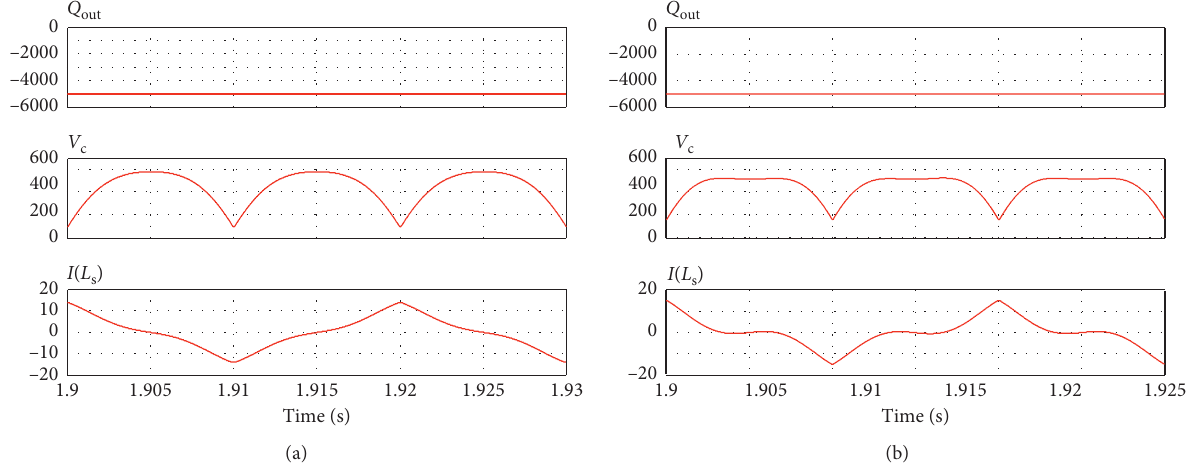
Figure 11: Comparison of reactive power optimization: (a) point A before optimization; (b) point B after